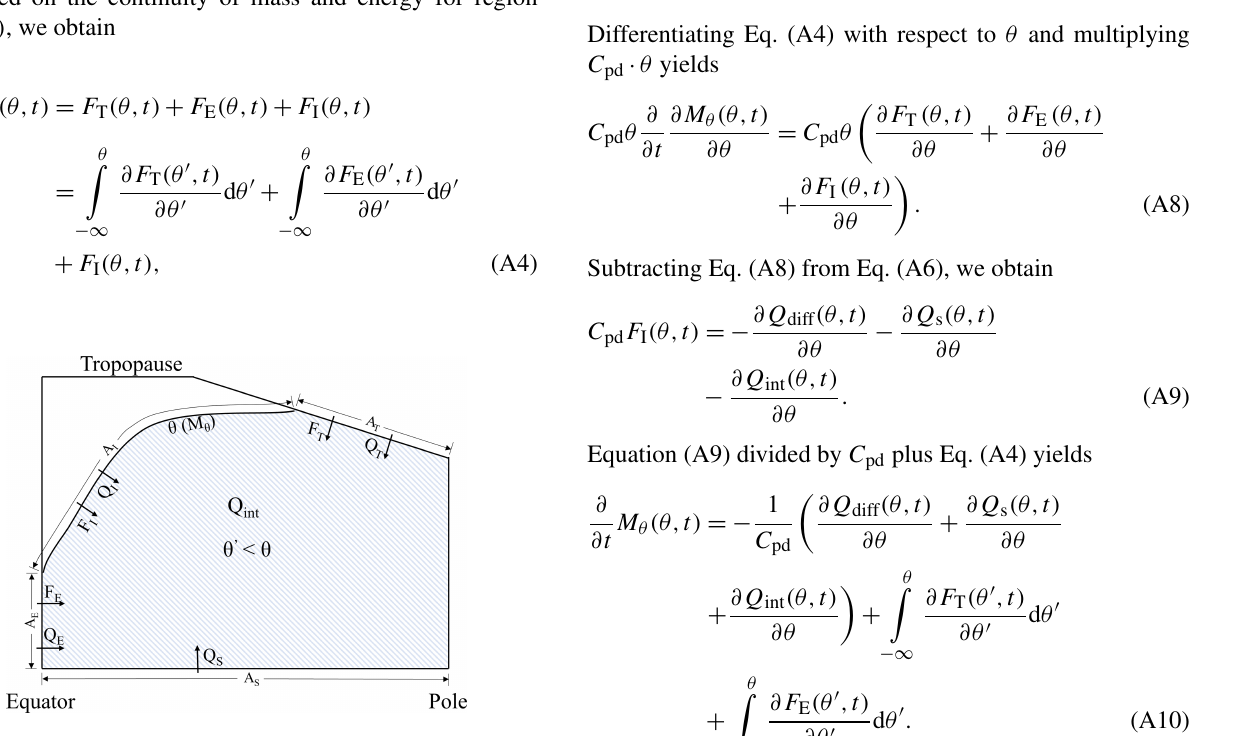
Figure A1. Illustration of terms defined in Table A1. Shaded area denotes the region R(θ,t) with θ (cid:48) lower than θ , which is the area of mass integration to yield M θ . The curve denotes a given θ or M θ